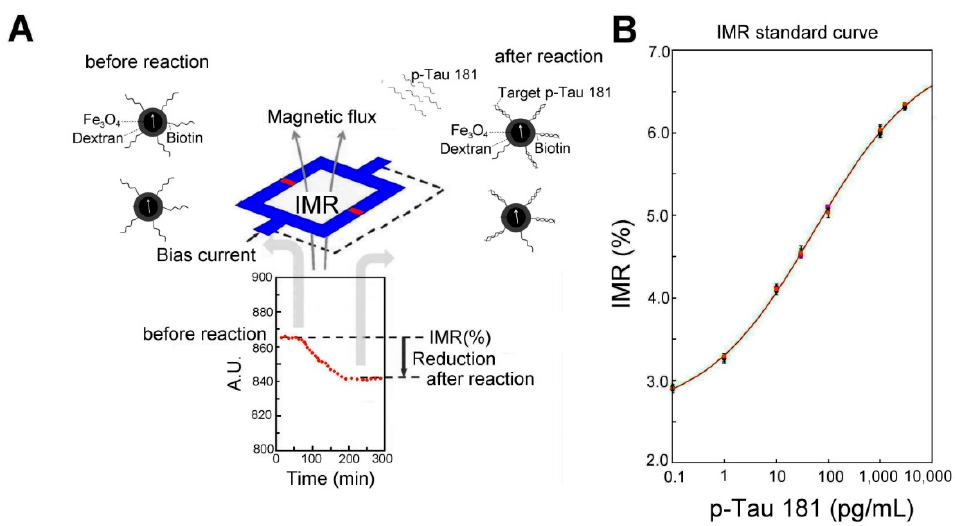
Figure 2. IMR detecting p-Tau 181 and standard curve: ( A ) A scheme of the physical mechanism of IMR assay. IMR is a method of assaying target molecules through measuring reductions in the mixed-frequency magnetic susceptibility of magnetic reagents resulting from the association between magnetic nanoparticles and target molecules. A magnetic nanoparticle coated with p-Tau 181 bioprobes is presented in the diagram. ( B ) Standard curve of p-Tau181 measured by IMR technique. The IMR value increased with the p-Tau 181 concentration.